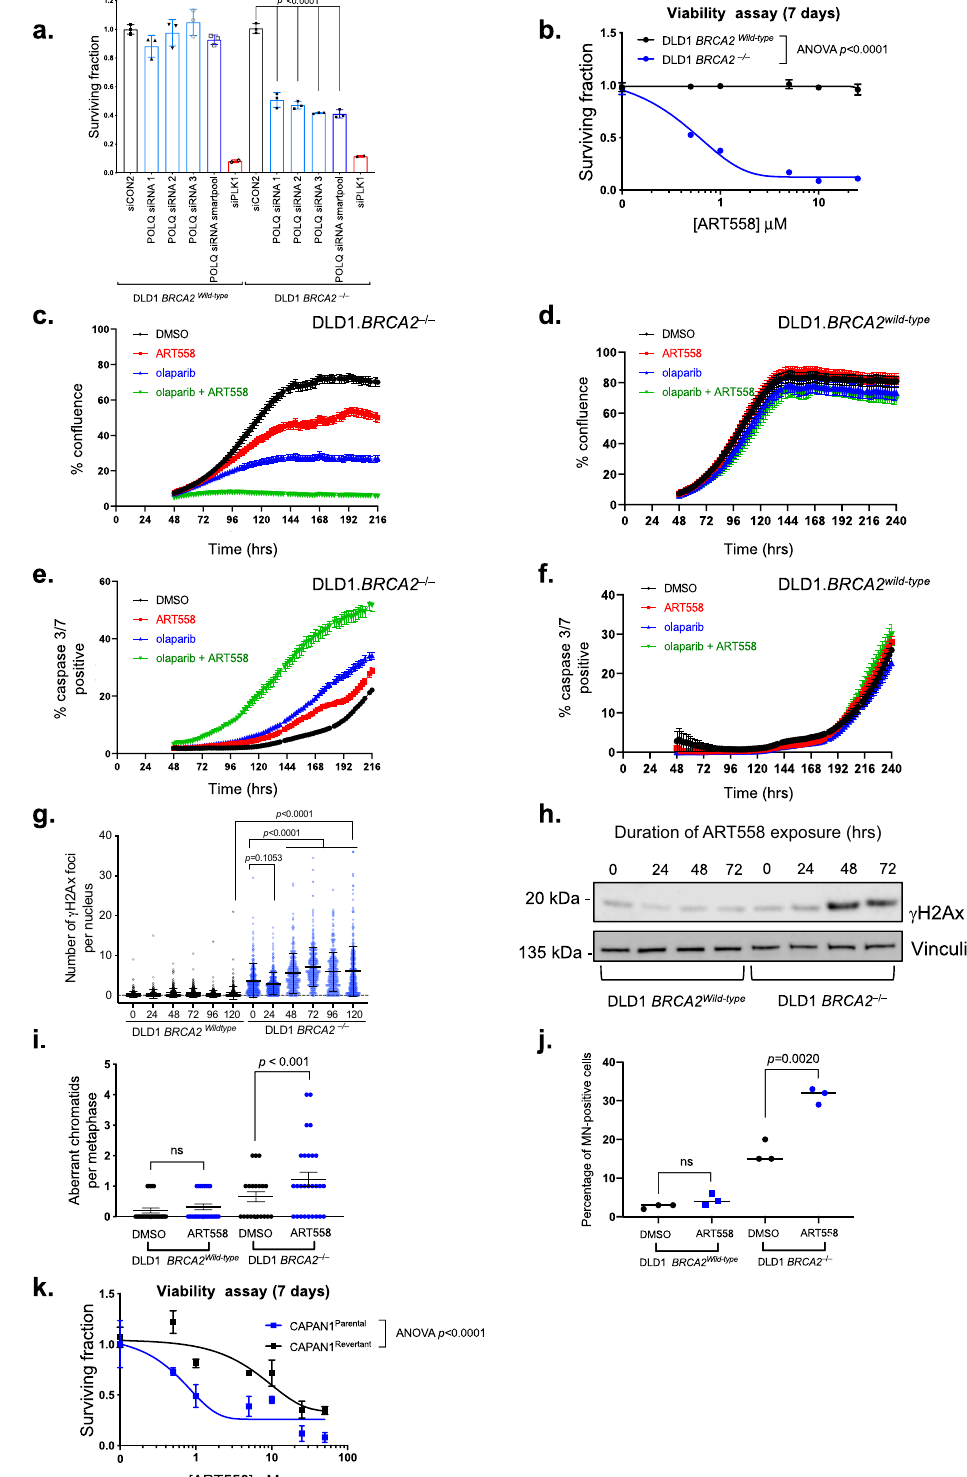
synthetic lethality between elements of this complex and Polq genetic deletion 39 . By comparing the ART558 screens in BRCA1 wild type vs. BRCA1 ‒ / ‒ cells, we noted that siRNA targeting Shieldin complex components SHLD2 and MAD2L2 sensitised BRCA1 ‒ / ‒ cells to ART558 but had no signi fi cant effect in BRCA1 wild type cells, suggesting that combined defects in BRCA1 and the Shieldin complex might be associated with